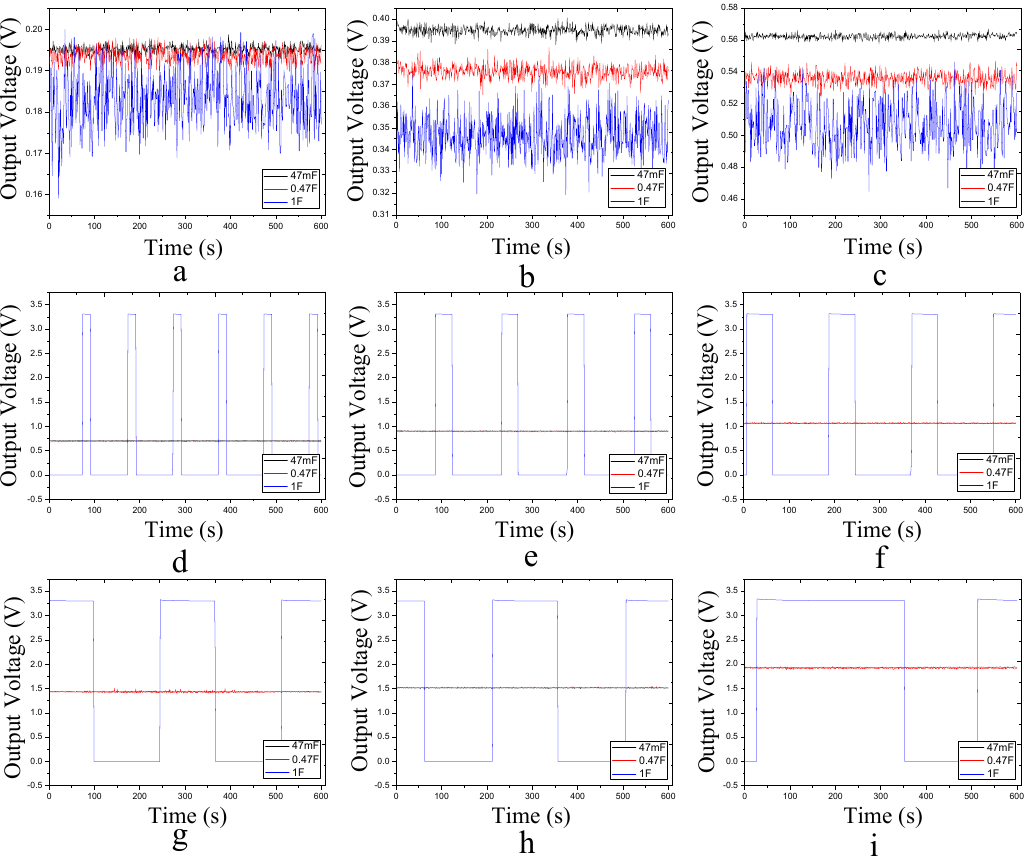
Figure 19. Output voltage waveforms of different loads and different capacitors. ( a ) load of 47 Ω ; ( b ) load of 100 Ω ; ( c ) load of 150 Ω ; ( d ) load of 200 Ω ; ( e ) load of 270 Ω ; ( f ) load of 330 Ω ; ( g ) load of 470 Ω ; ( h ) load of 510 Ω ; ( i ) load of 680 Ω .